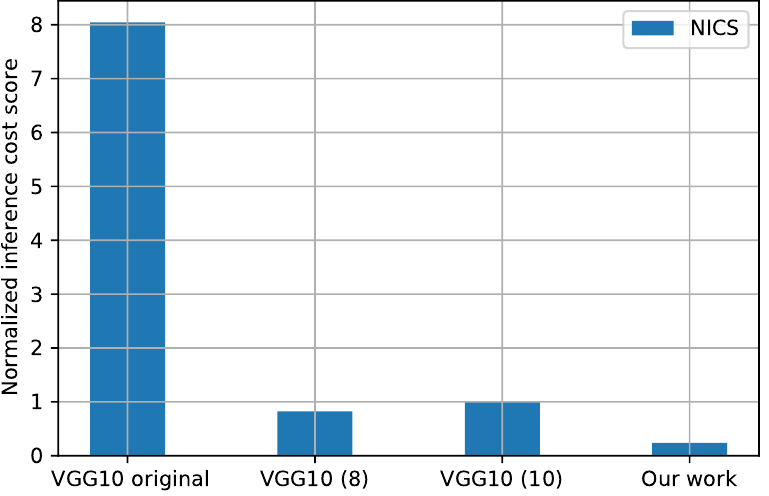
Figure 9. Comparison of the quantized VGG10 1D-CNN model versus the